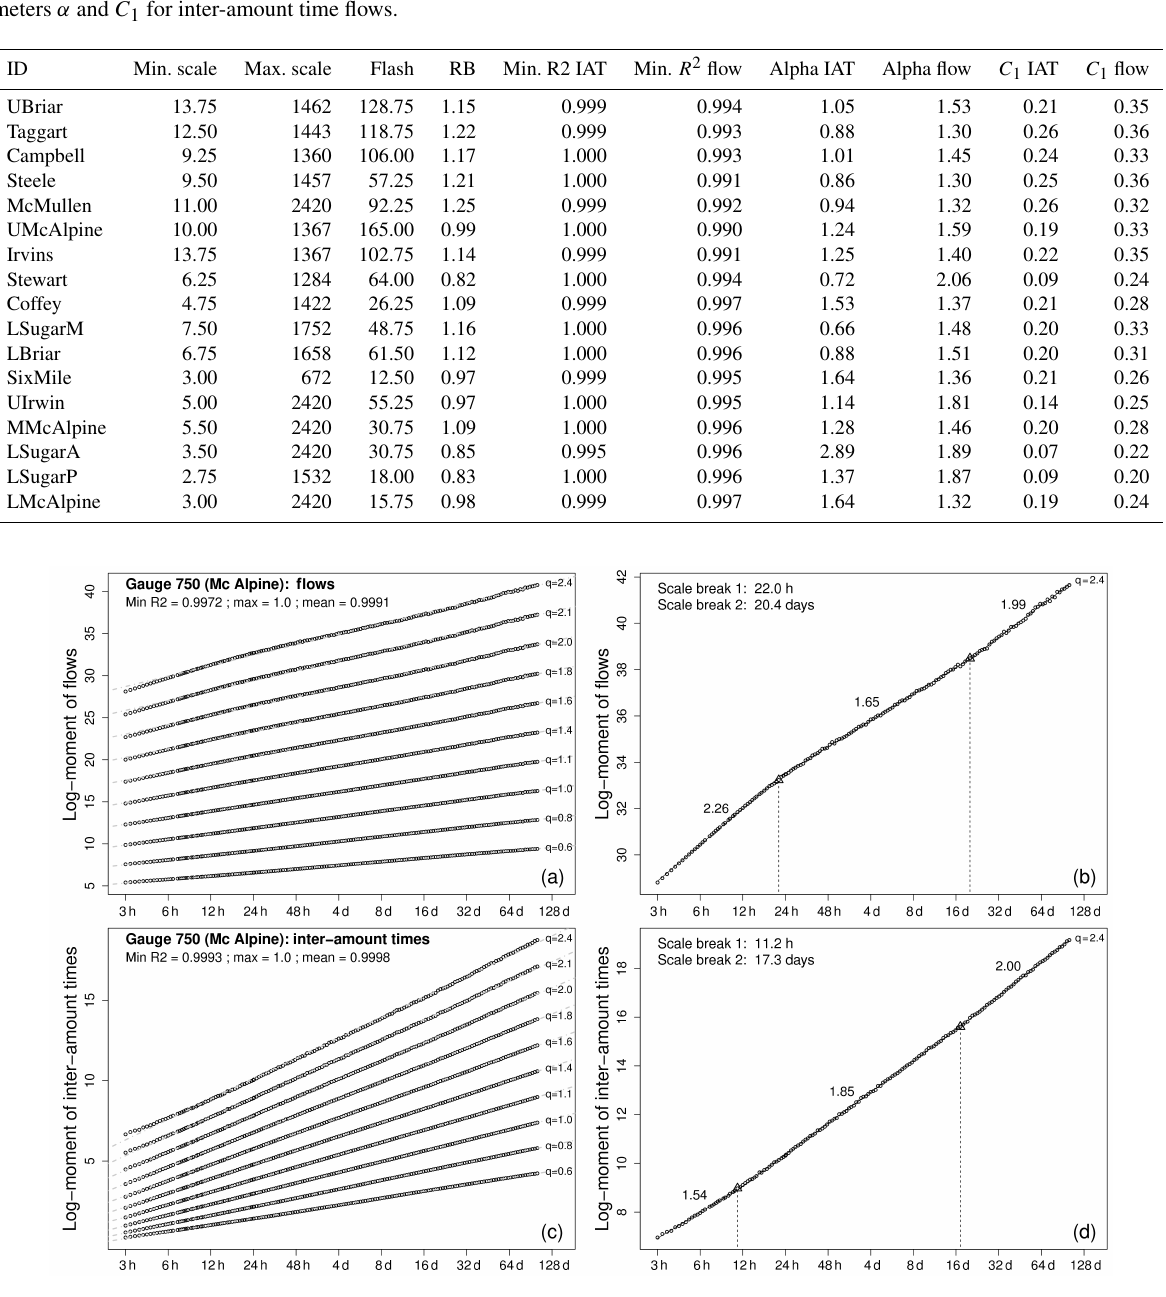
Figure 11. Example of log–log plots for flows and inter-amount times (a, b) , for Mc Alpine Creek, illustrating departures from linearity at high-order moments. Reported R 2 values are for the entire range of results, without scale breaks. Log–log curve for moment q = 2 . 4 illustrating scale breaks for flows and inter-amount times (c, d)